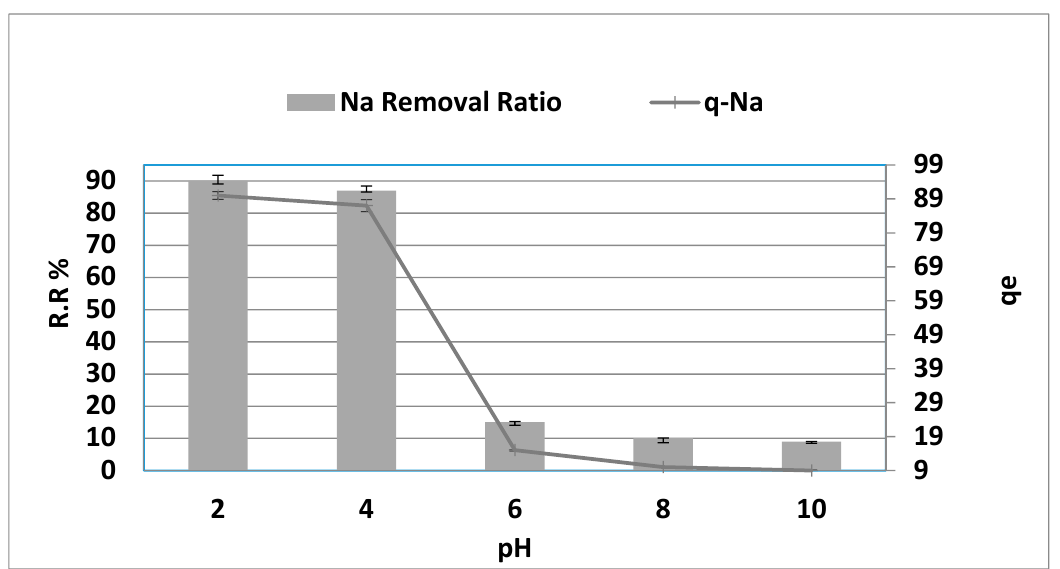
Figure 5. pH effect on NaCl adsorption removal and capacity at adsorbent dosage = 8 g/0.1 L, duration = 150 min, agitation rate = 300 rpm at 270 °C.